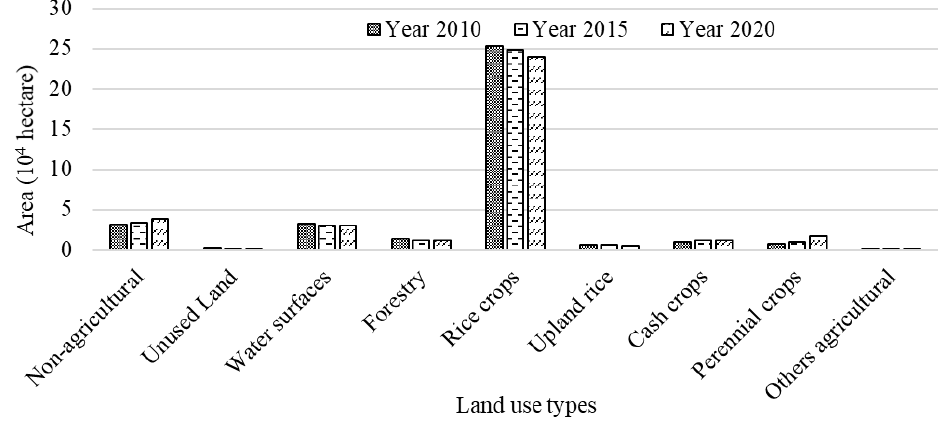
Figure 9. Changes in the area of land use types in the period of 2010 – 2020 in An Giang province.